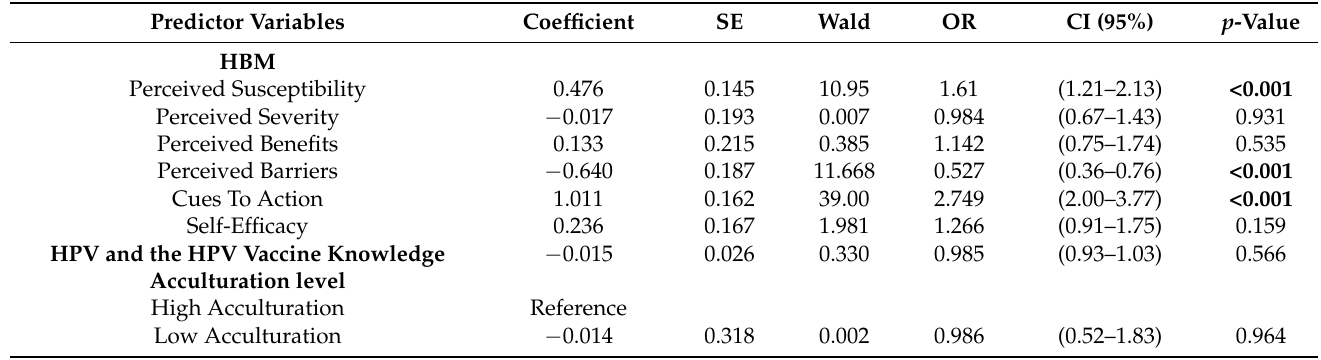
Table 7. Multivariate logistic regression model of HPV vaccination behavior of foreign-born col- lege